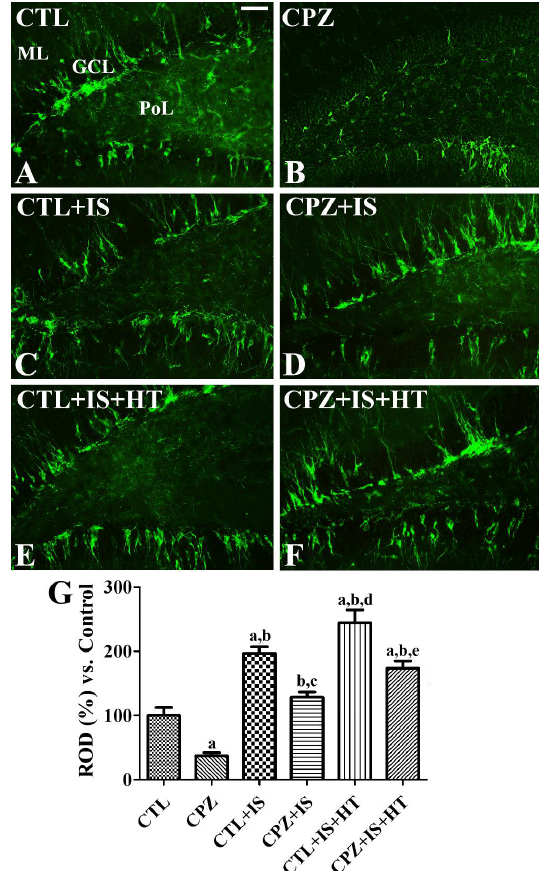
Figure 10. Doublecortin (DCX) immunohistochemistry in the gerbil hippocampal dentate gyrus of the CTL ( A ), CPZ ( B ), CTL + IS ( C ), CPZ + IS ( D ), CTL + IS + HT ( E ), and CPZ + IS + HT ( F ) groups. DCX-immunoreactive neuroblasts have a round cytoplasm with dendrites that extend into the molecular layer (ML). Note that DCX-immunoreactive structures were most abundant in the CTL + IS + HT group and fewest in the CPZ group. GCL, granule cell layer; PoL, polymorphic layer. Scale bar = 50 µ M. ( G ) RODs were expressed as a percentage of the DCX immunoreactivity detected compared with that of the CTL group in the hippocampal dentate gyrus for each section ( n = 5 per group, a p < 0.05, significantly di ff erent from the CTL group; b p < 0.05, significantly di ff erent from the CPZ group; c p < 0.05, significantly di ff erent from the CTL + IS group; d p < 0.05, significantly di ff erent from the CPZ + IS group; e p < 0.05, significantly di ff erent from the CTL + IS + HT group). Error bars indicate standard